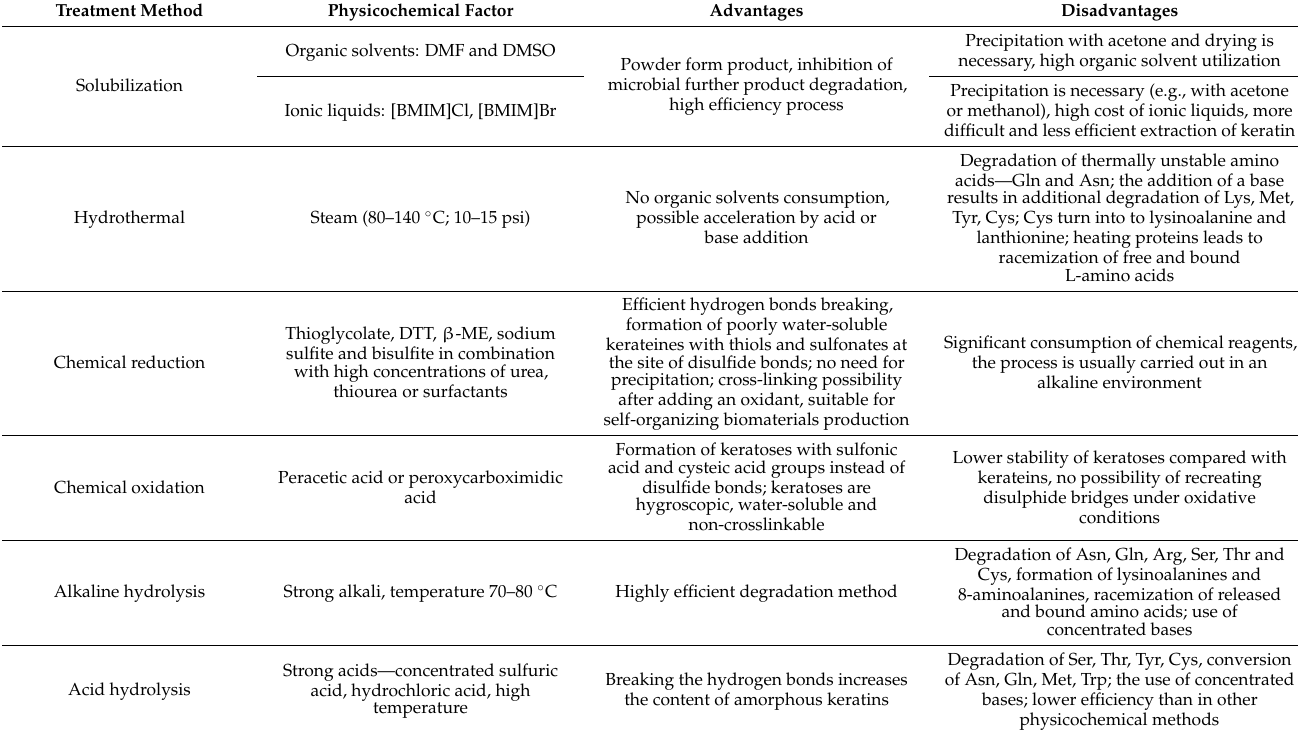
Table 2. Comparative analysis of various physicochemical treatment methods with their advantages and disadvantages